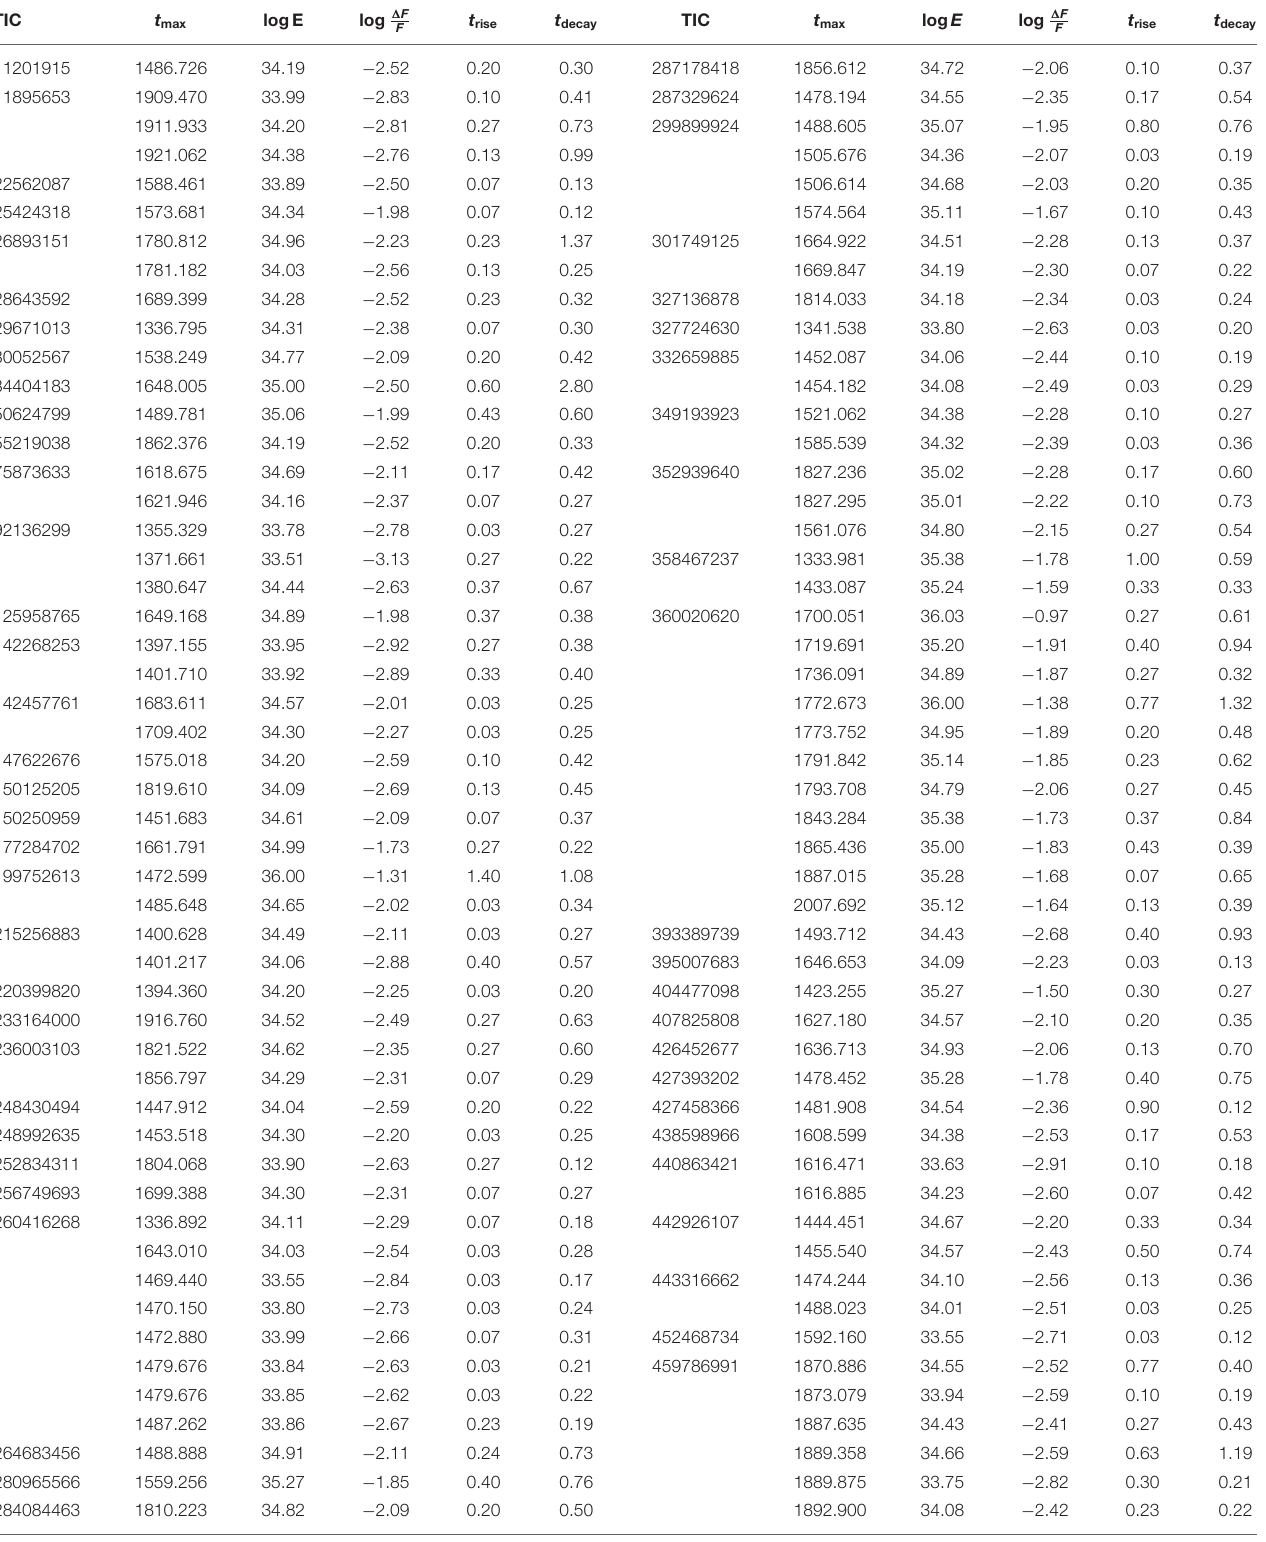
TABLE 3 | List of individual flares for stars in Table 2 .